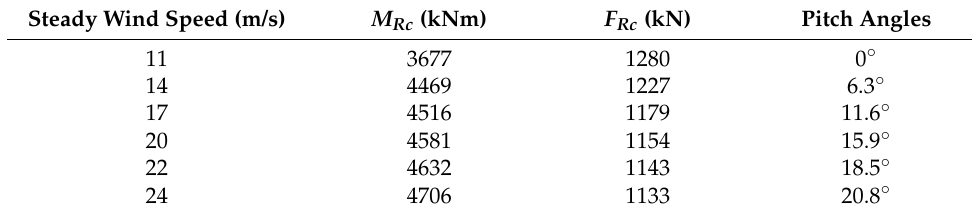
Figure 4. Coordinate systems for stationary hub loads. Table 4. Ultimate loads and pitch angles for CPC.